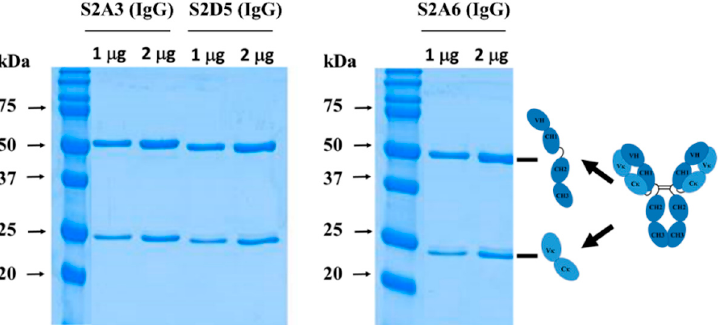
Figure 3. Production of anti-MERS-S2P IgGs. SDS-PAGE analysis under reducing conditions (with DTT) of anti-MERS-S2P IgGs purified from culture media of HEK293F cells transiently transfected with heavy- and light-chain expression vectors. IgG, immunoglobulin G.